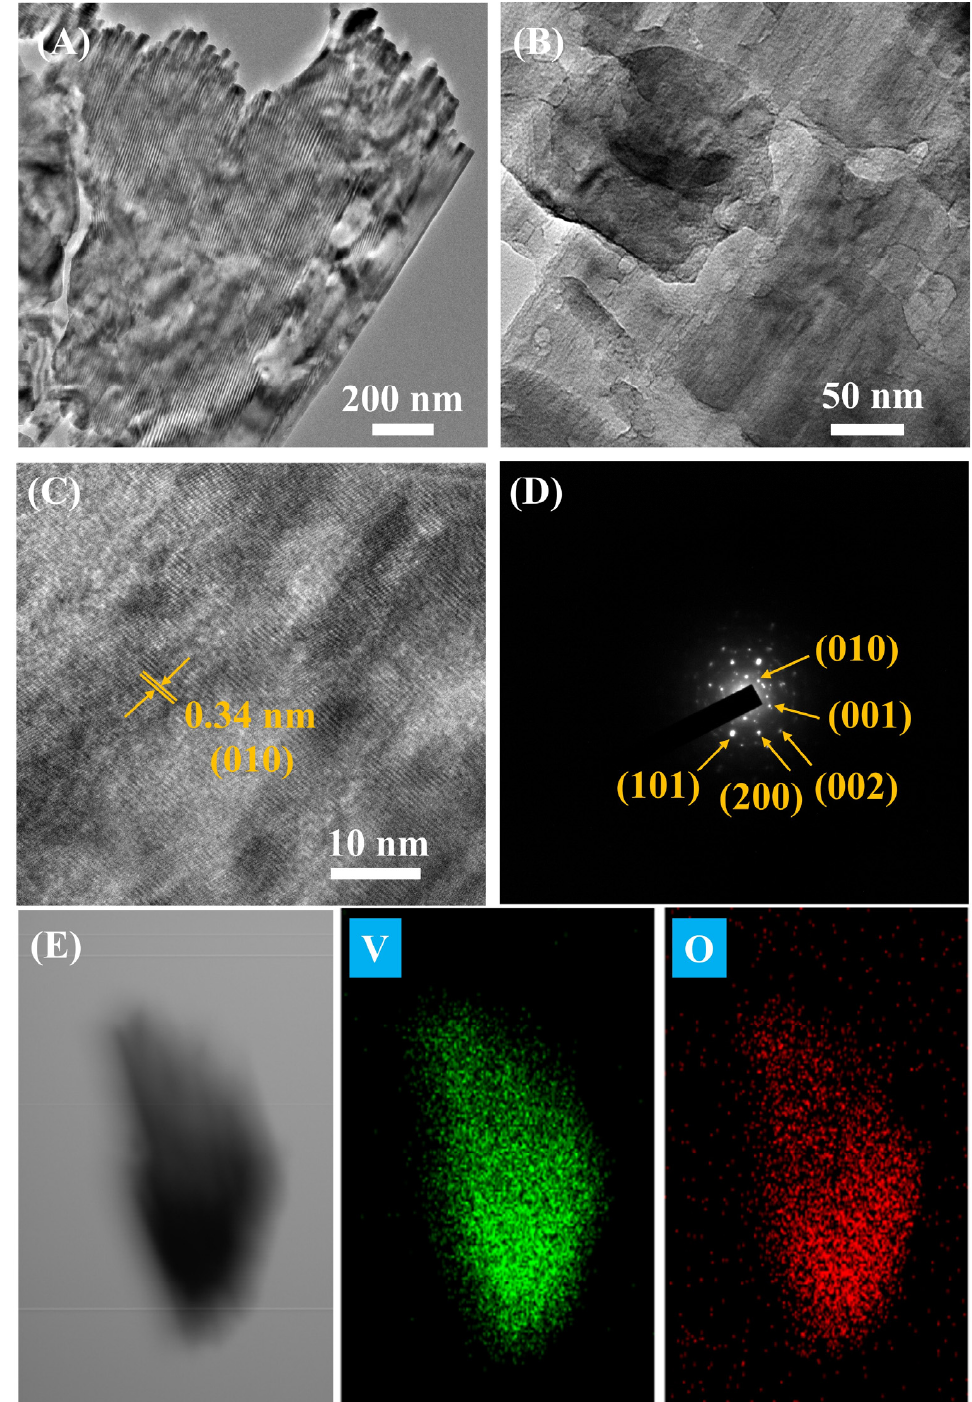
Figure 5. ( A – C ) TEM images, ( D ) SEAD, and ( E ) EDS elemental mapping of annealed V 2 O 5 material. V and O labeled images show the distribution of vanadium (V) and oxygen (O)